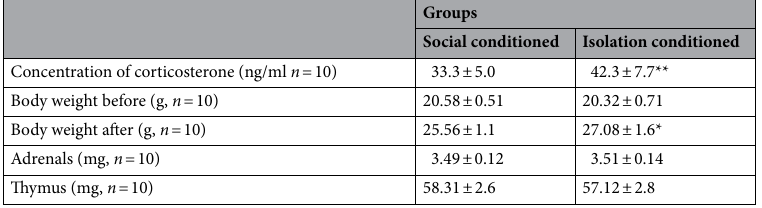
Table 2. Absolute body weight (g) and organ weights (mg) in both isolated and social conditioned mice. * P < 0.05 and ** P < 0.01 compared to social conditioned